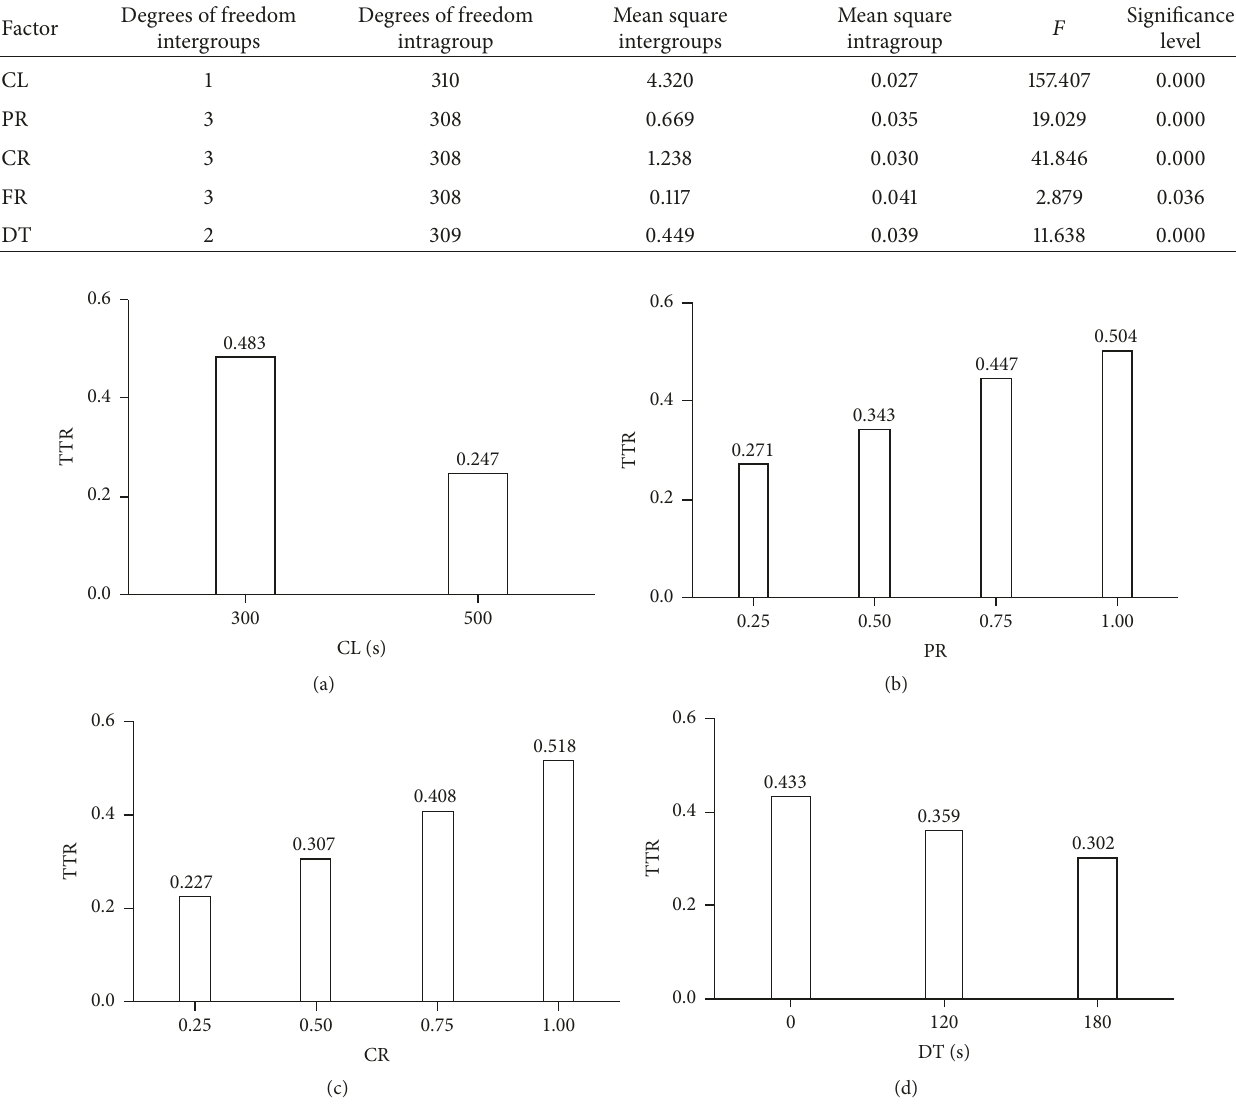
Figure 8: The impact of these four characteristics indexes on